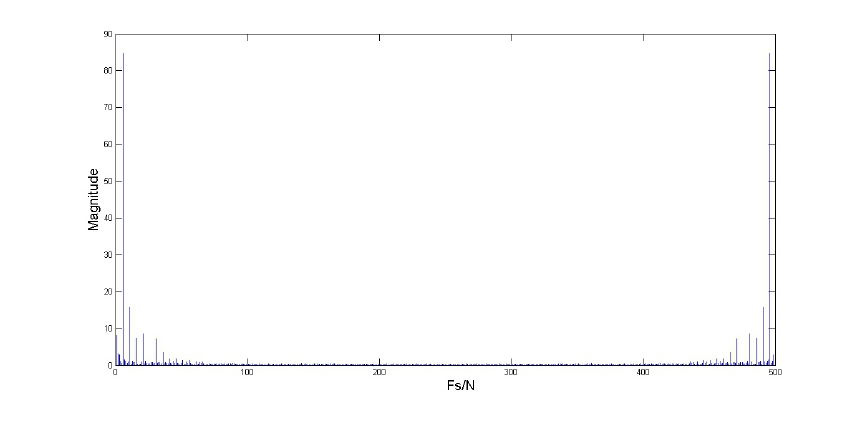
Figure 7. Fourier spectrum X ( k ) .